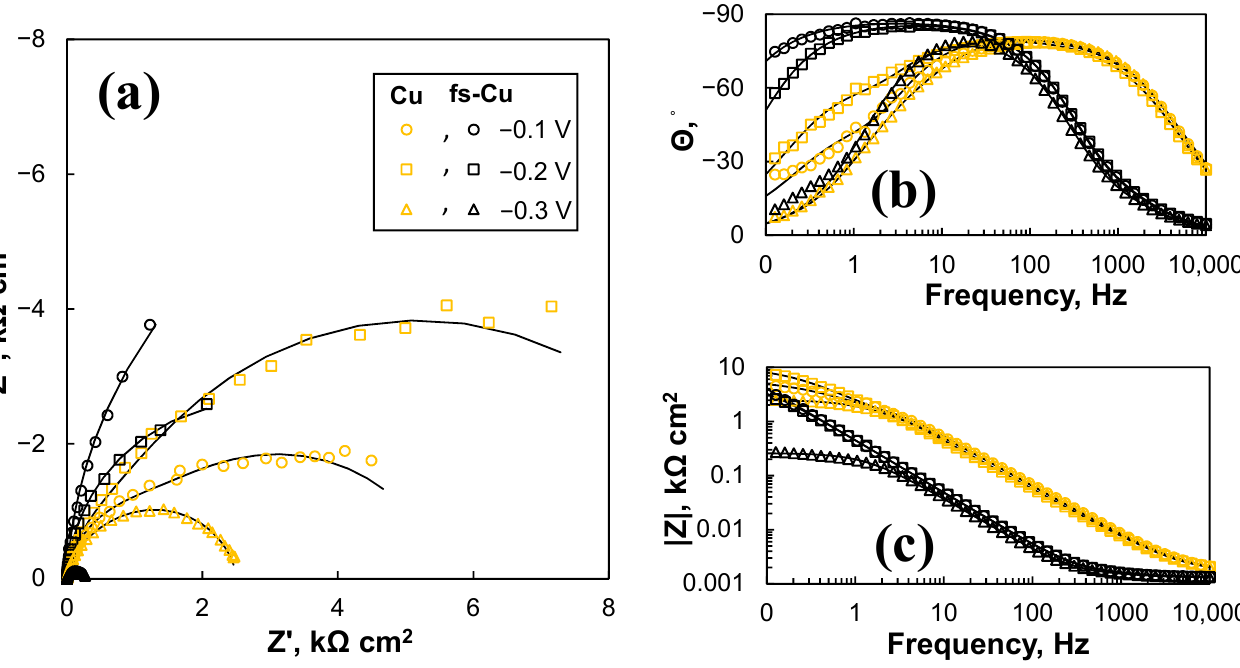
Figure 8. The EIS spectra of the plain Cu and fs-Cu surfaces in the ( a ) Nyquist complex coordinates and ( b , c ) Bode coordinates. Solid lines show equivalent circuit fits.